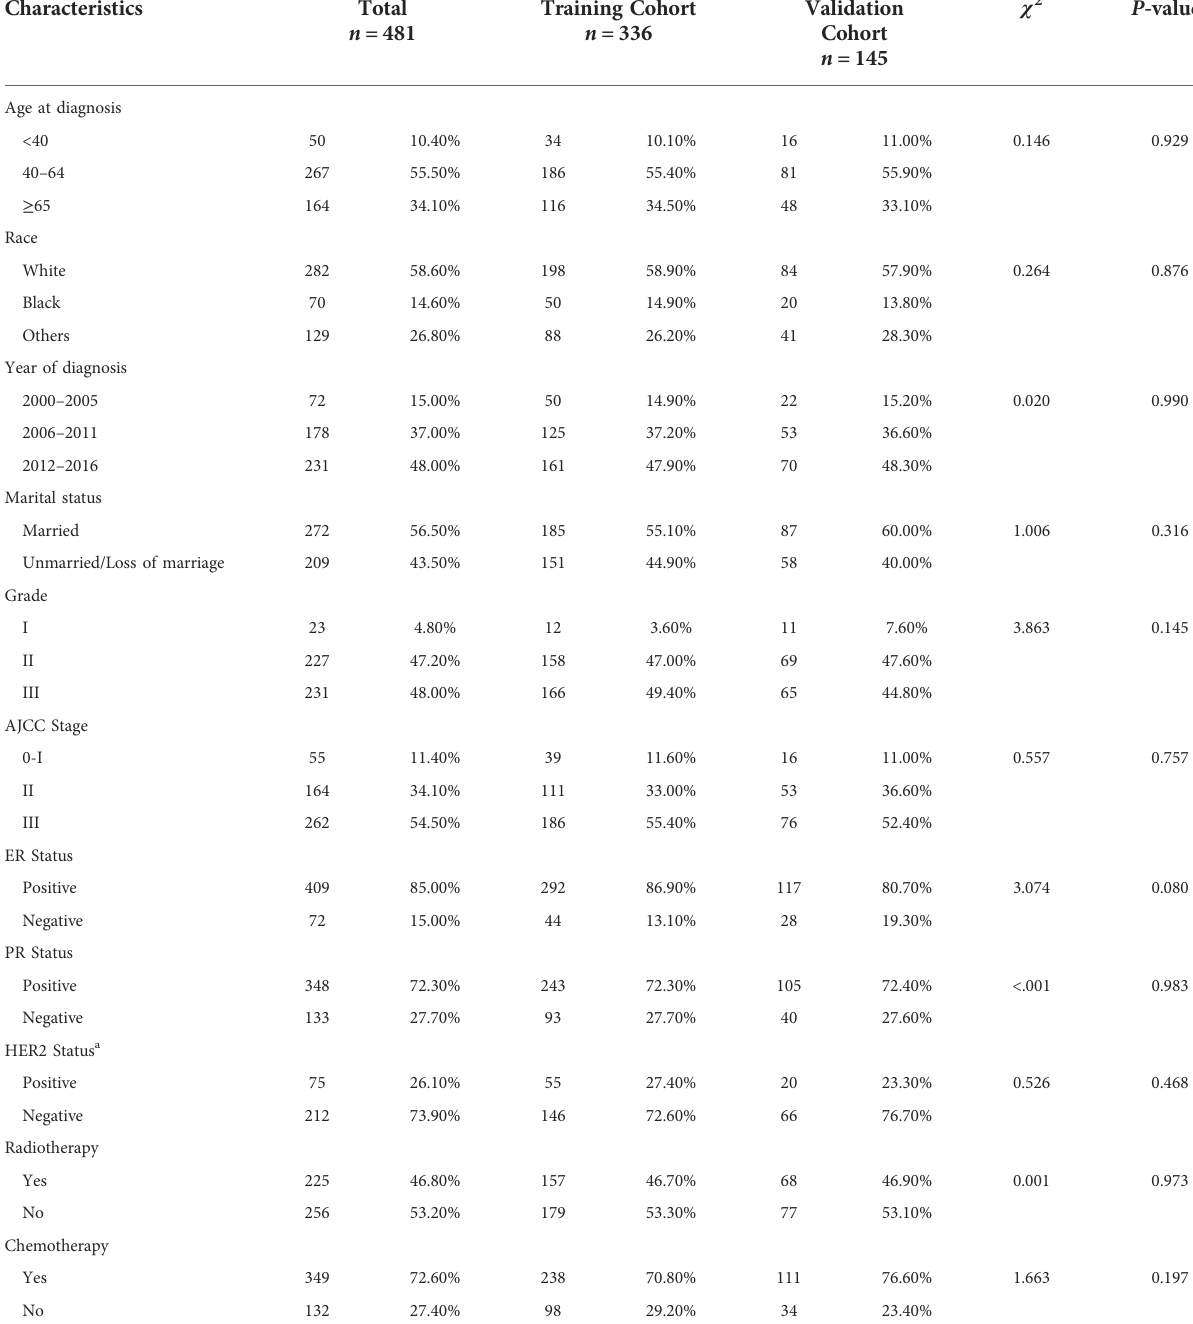
TABLE 1 Patient clinical and pathological